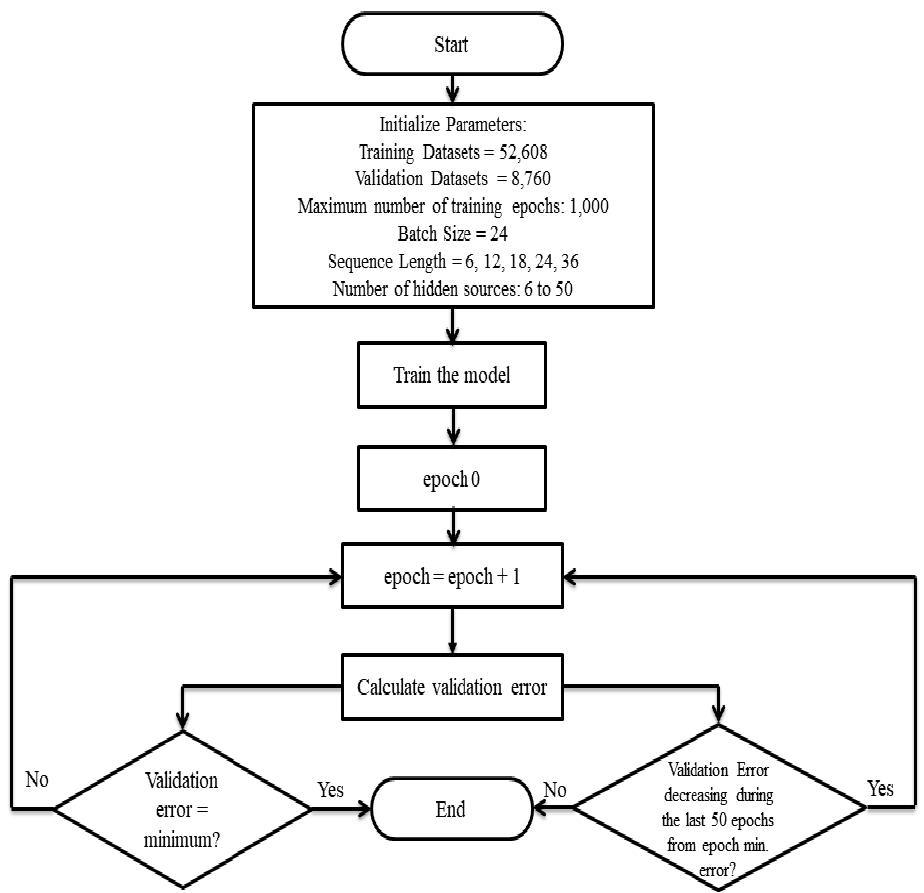
Figure 2. Workflow diagram of the LSTM model employed in the study.